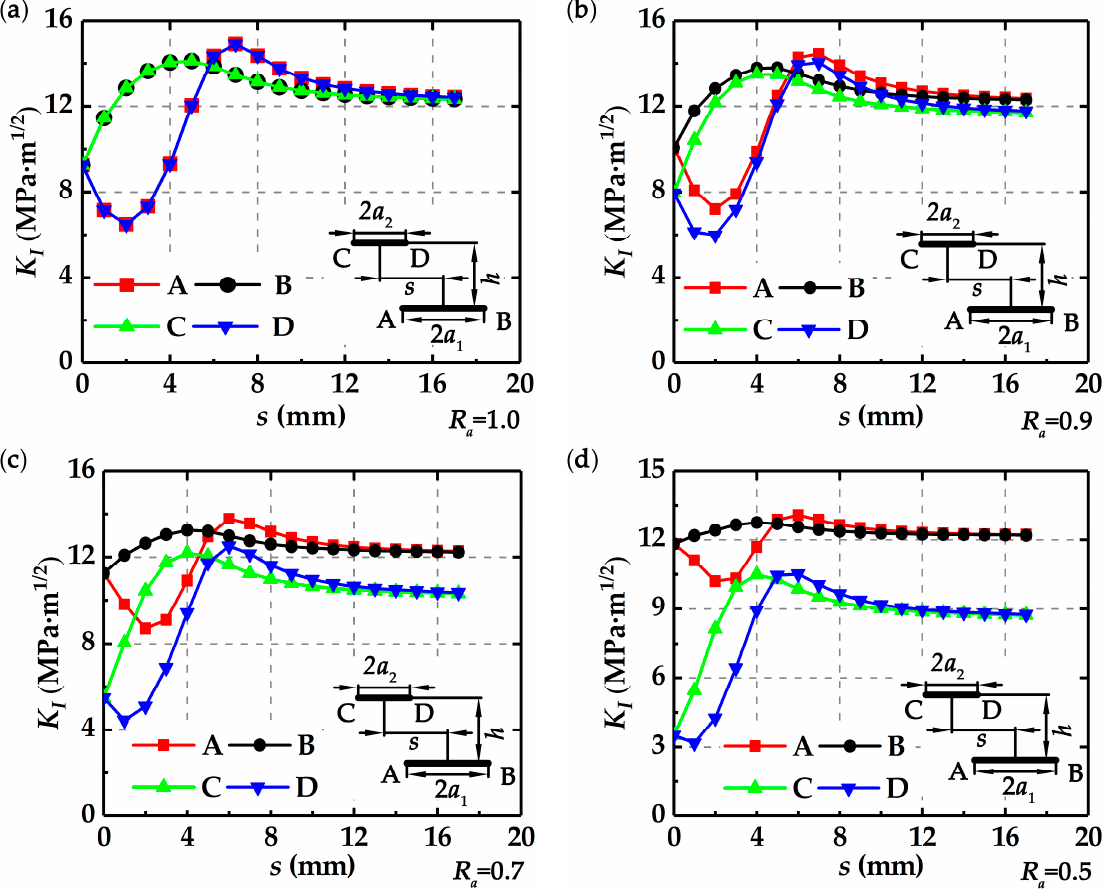
Figure 4. Changes of K I with s at h = 2.5 mm for different R a : ( a ) R a = 1.0, ( b ) R a = 0.9, ( c ) R a = 0.7, and ( d ) R a = 0.5.